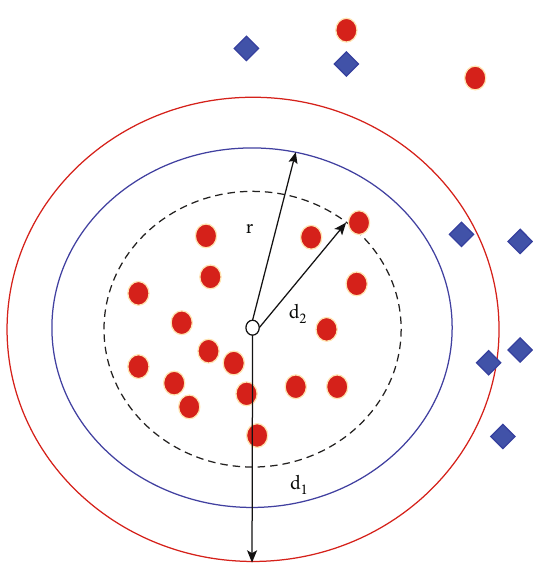
Figure 1: De fi nition of coverage radius r